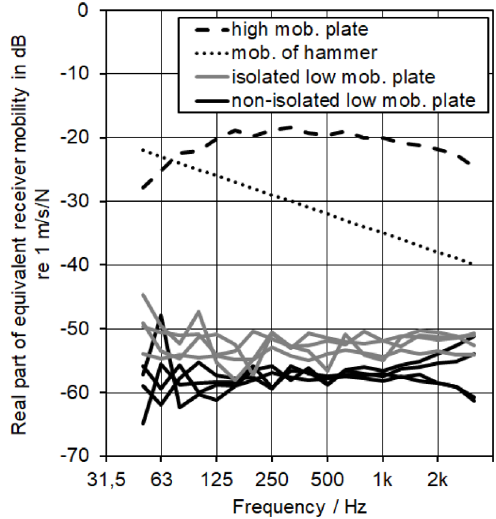
Figure 6. Loss factors of the isolated low mobility and the high mobility reception plates and minimum loss factor required by [6].